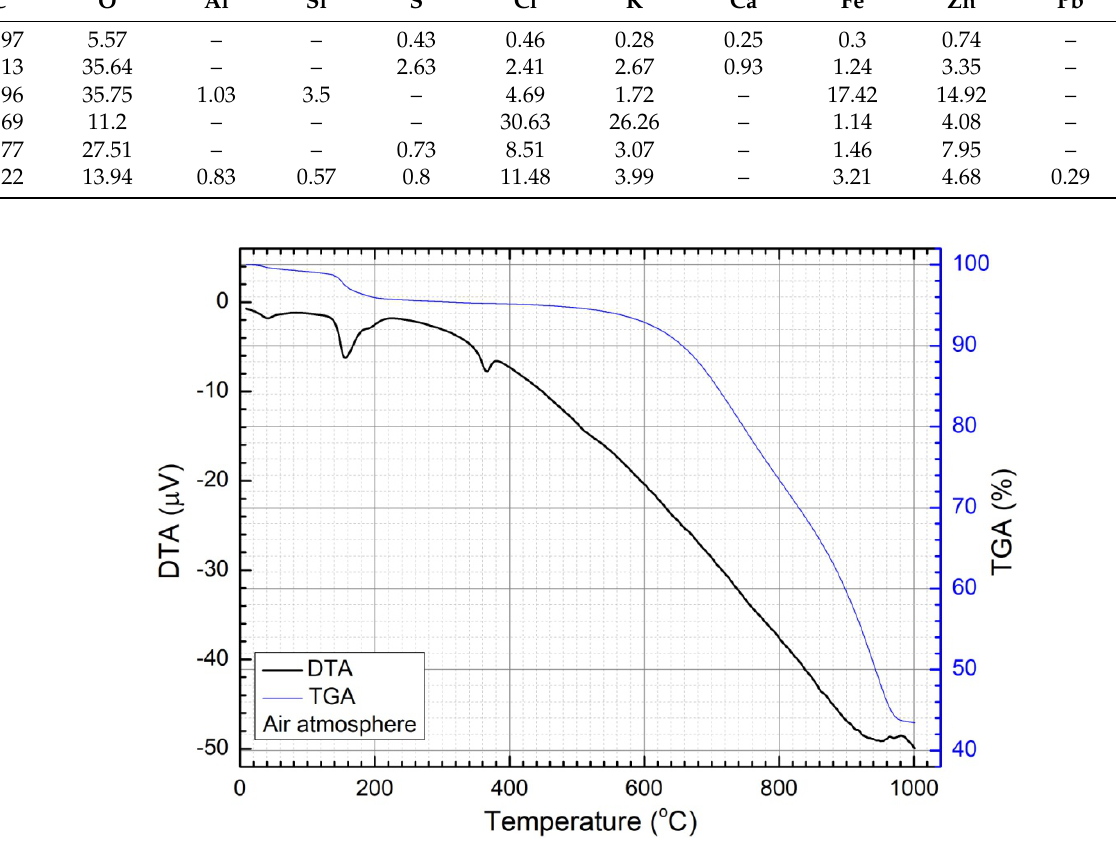
Figure 7. Thermogravimetric analysis (TGA) and differential thermal analysis (DTA) for the coagulum.